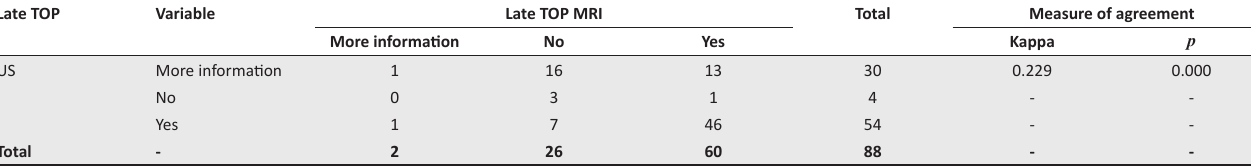
TABLE 5: Late termination of pregnancy ultrasound compared to magnetic resonance imaging. Late